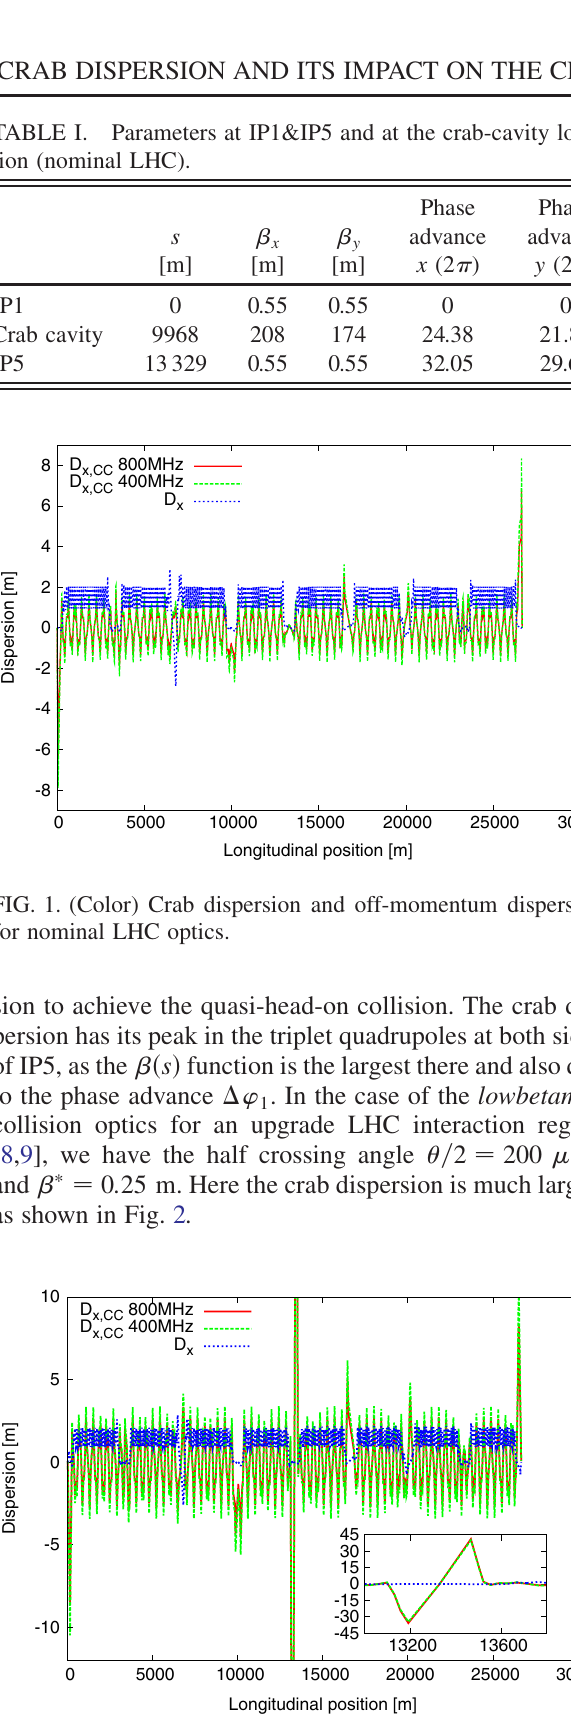
FIG. 3. (Color) The orbit deviation at IP5 with a linear crab kick (ideally low crab frequency), for two different crossing angles.